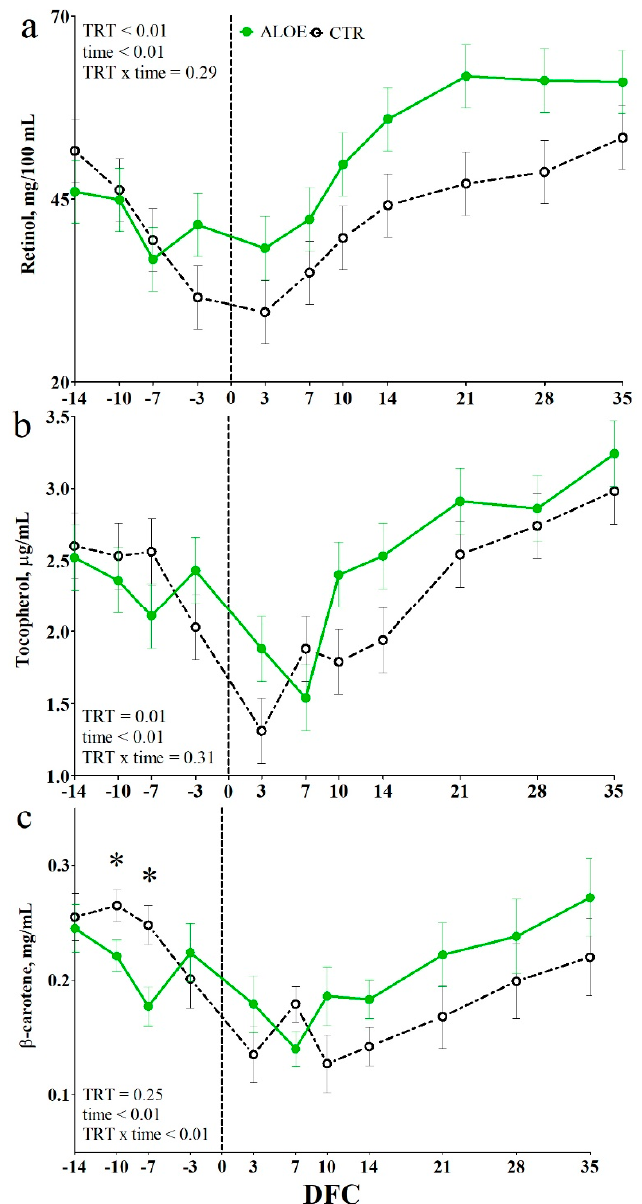
Figure 5. Time course of plasma concentrations of retinol ( a ), tocopherol ( b ), and β -carotene ( c ) in dairy cows receiving placebo water (CTR; black dotted line) or cows receiving a drench of 200 g / d of Aloe arborescens Mill. whole plant homogenate between − 14 and 14 days from calving (AAM; green solid line). * is p < 0.05; DFC is days from calving.